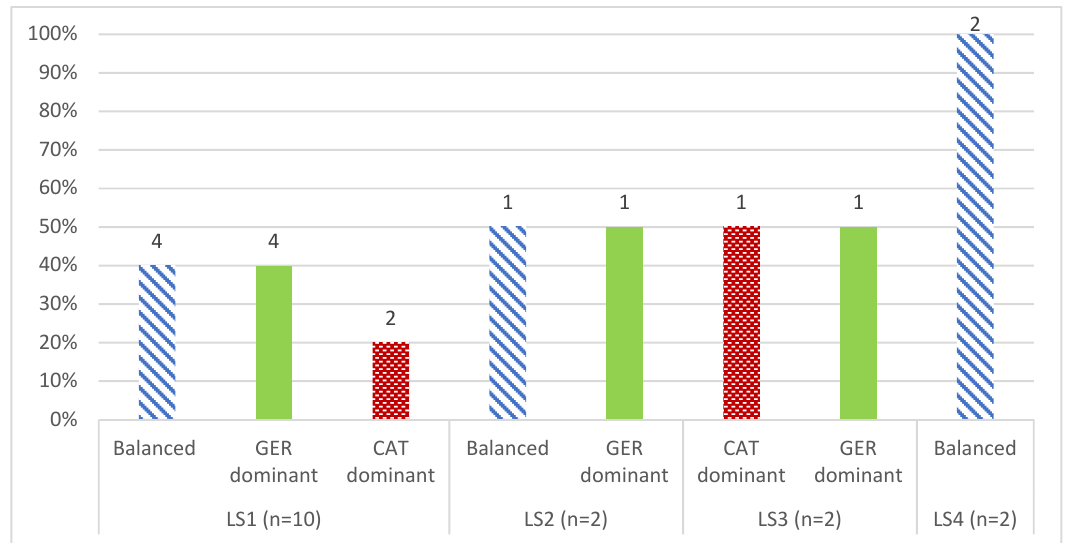
Figure 4. Classification of children according to LS and their dominance.